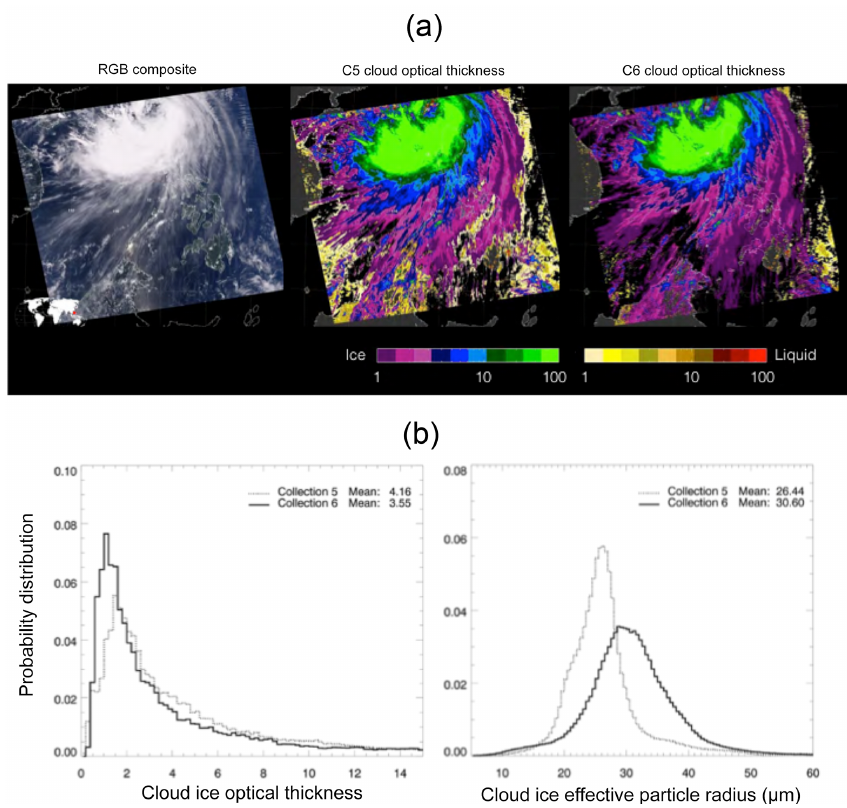
Figure 8. (a) Example retrieval results for an Aqua MODIS data granule (MYD06 2014, 20 September, 05:30UTC). The RGB composite is shown in the left panel, while IOT retrievals for collections 5 and 6 are shown in the center and right panels, respectively. Note the difference in the phase determination between the two collections. (b) Collection 5 and 6 distributions of ice cloud optical thickness and effective radius derived from a combination of the MODIS 0.86 and 2.1µm channels for the data granule of (a) . The distributions are limited to common pixels for which both collections agree that the pixel has an ice phase and the retrievals were successful. The IOT modes are at about 1.5 and 1.1 for C5 and C6, respectively, representing about a 27% reduction in the most recent collection; the effective radius modes increase by about 15%. The mean for the range shown in the plots is given in the